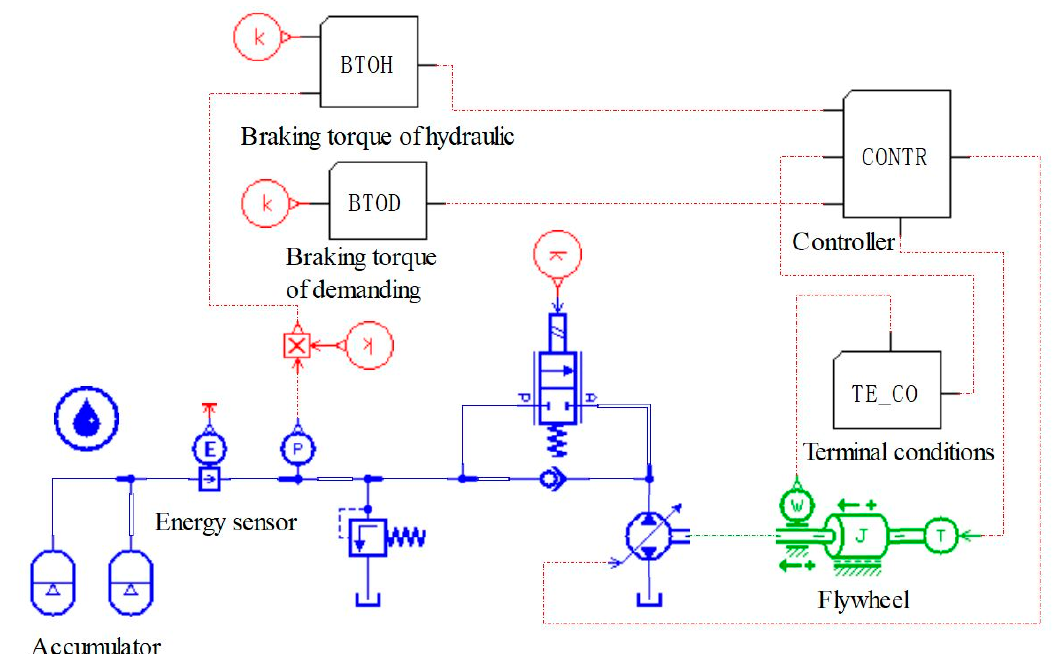
Figure 4. Modeling of the regenerative braking system and the energy management strategy.